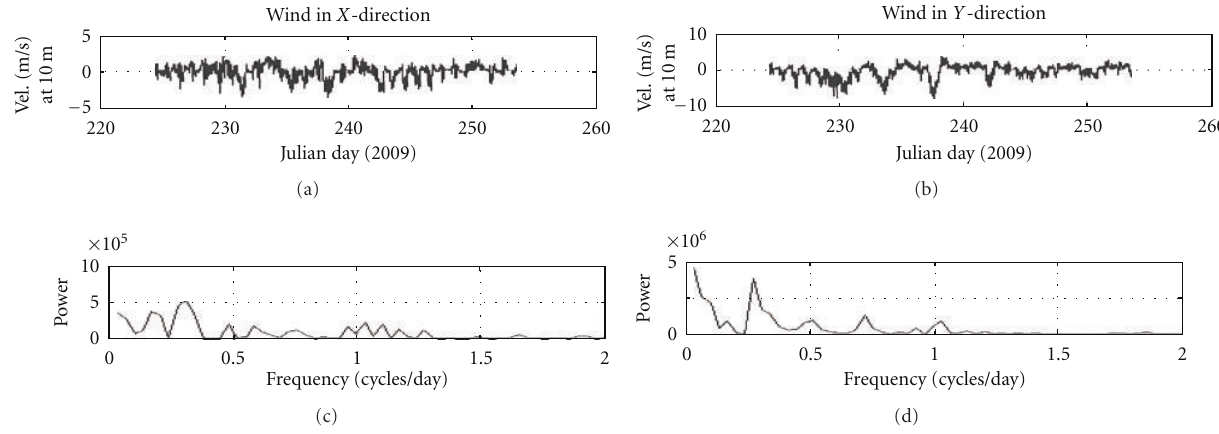
Figure 2: The top panels are measured local wind components from an onshore 3-meter high portable station, and lower panels are frequency spectra of the wind components.